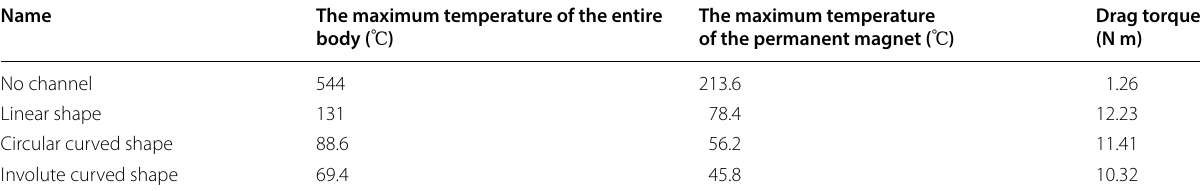
Table 2 Parameter comparison of temperature